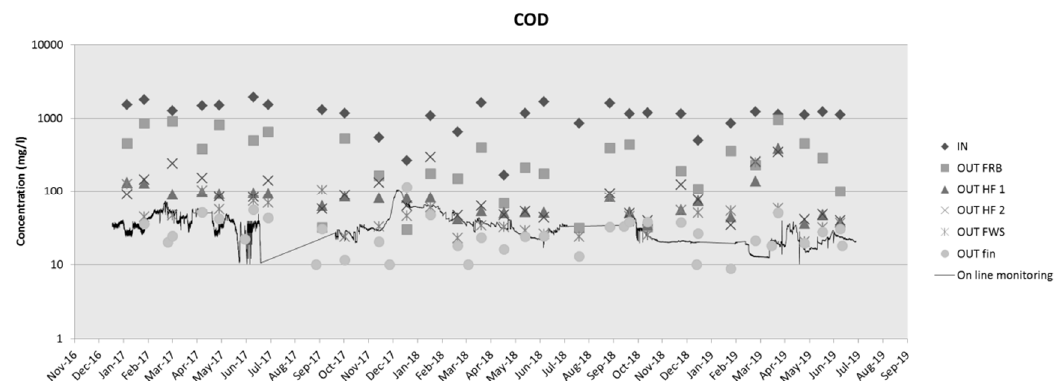
Figure 4. Samples and online sensors results for the COD monitoring of the CW of Cecchi winery. Monitored samples were taken from 19 January 2017 to 14 June 2019 at the different stages of the CW of Cecchi winery: influent (IN); effluent from the 1st stage FRB beds (OUT FRB); effluent from the 2nd stage refurbished HF bed (out HF 1); effluent from the 2nd stage HF beds built during the 2009 upgrade (OUT HF 2); effluent from the 3rd stage FWS bed (OUT FWS); effluent from the official effluent sampling point, after the optional sand filter (OUT fin). The online sensor monitored the final effluent, i.e., OUT fin, throughout the sampled period with a time span of 30 min; missing data from the online sensor are filled with a linear interpolated line.